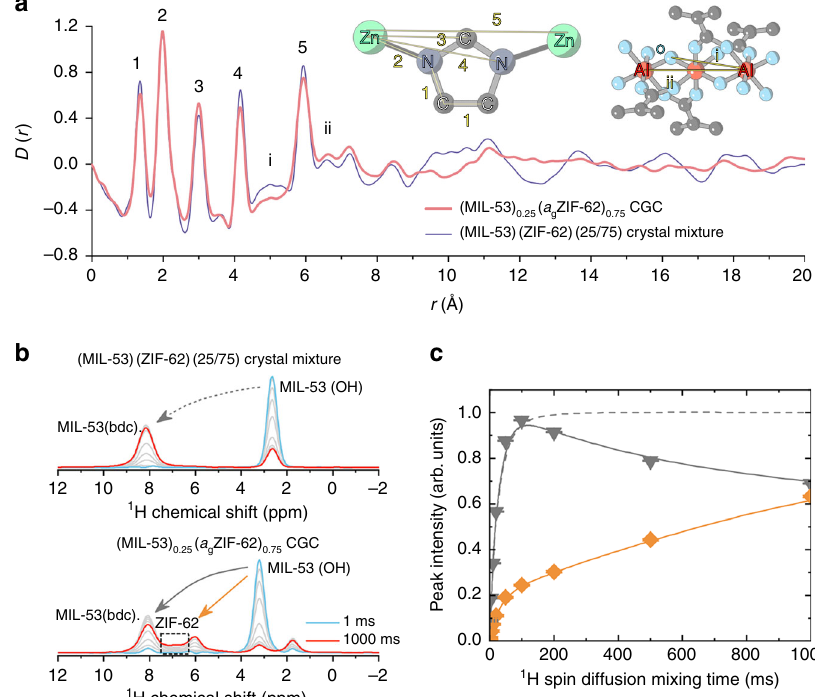
Fig. 3 Phase distribution in the (MIL-53)(ZIF-62)(25/75) and (MIL-53) 0.25 ( a g ZIF-62) 0.75 CGC. a Pair distribution function (PDF) D(r) calculated via Fourier transform of the X-ray total scattering structure factor S(Q) for the crystal mixtures and CGC. The inset shows the scheme for PDF peak assignment. b Slices along the indirectly detected dimension through the 2D 1 H spin-diffusion NMR spectra. Slices were taken at chemical shift of about 3 ppm, and show how polarisation transfer between the OH groups of MIL-53 and all other protons of the samples proceeds. c Spin-diffusion curves obtained by extracting integrated intensities of selected peaks within the slices through the 2D 1 H spin-diffusion NMR spectra. Dashed grey line describes proton polarisation transfer between OH groups and BDC linkers of the crystal mixture, grey triangles and solid line describe polarisation transfer between OH groups and BDC linkers of MIL-53 within CGC, and orange diamond signs and solid line describe polarisation transfer between the OH groups of MIL-53 and imidazolate linkers of ZIF-62 within